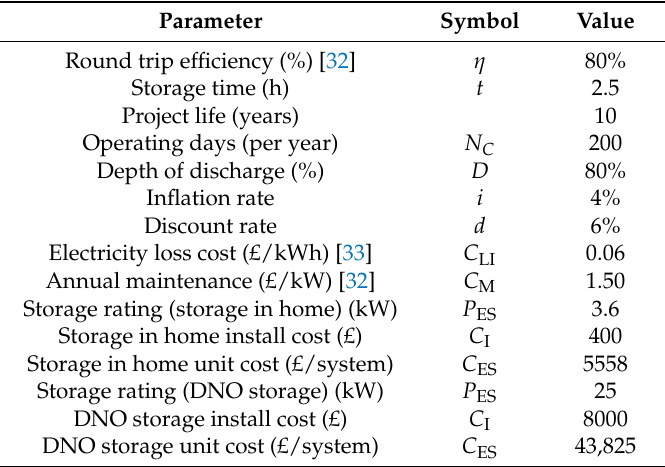
Table 3. Summary of energy storage cost parameters.